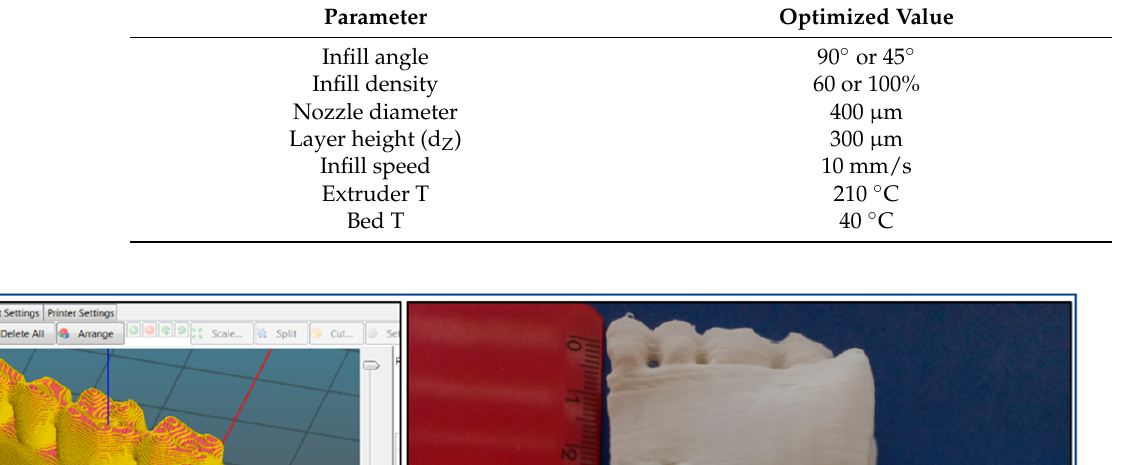
Table 1. Optimized parameters for PLA processing.